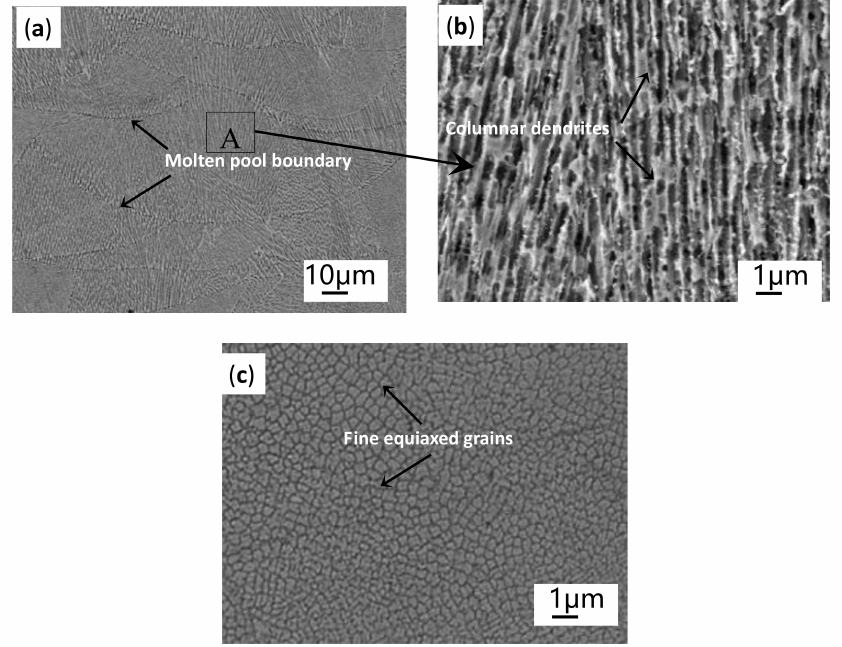
Figure 7. Typical SEM micrographs of as-built sample:( a ) dendrites growing through multilayers on cross-section (X–Z plane); ( b ) clear columnar dendrites on the vertical section in the melt pool’s central fusion zone, which is the high-magnified micrograph of the area A in Figure 6a; ( c ) the fine equiaxed grains on the X-Y plane in the melt pool’s central fusion